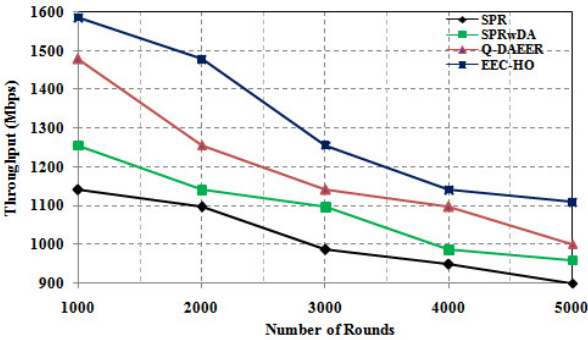
Figure 10. Throughput with number of simulation rounds